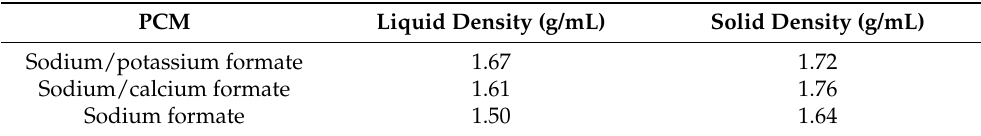
Table 3. Solid and liquid density of formate